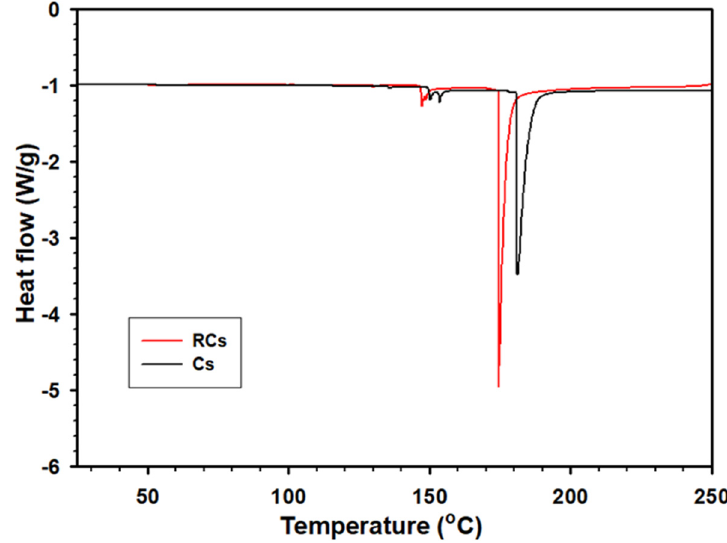
Figure 7. DSC curves of Cs and RCs.